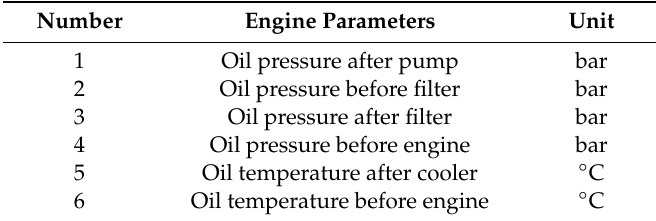
Table 2. Main working parameters of an engine lubrication system.